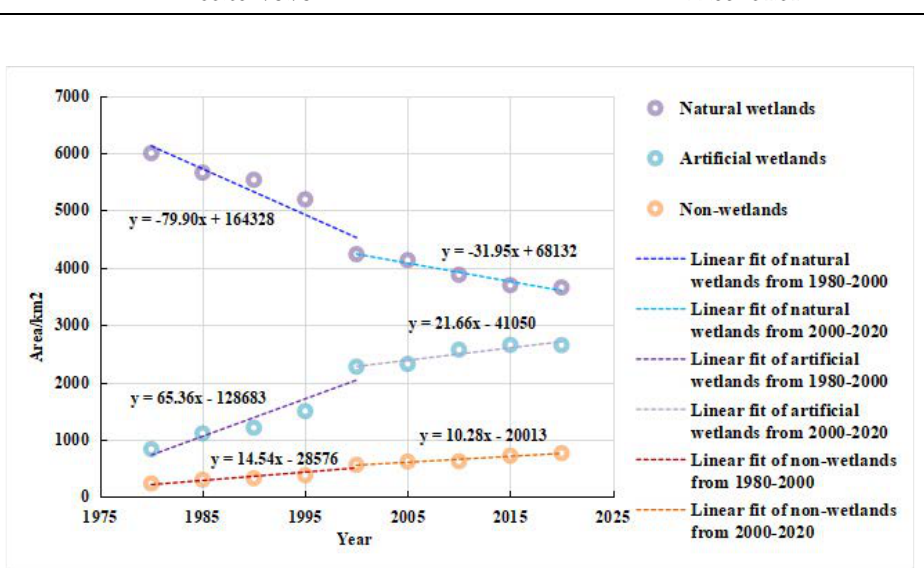
Figure 4. Areas of different landscape types from 1980 to 2020 (unit: km 2